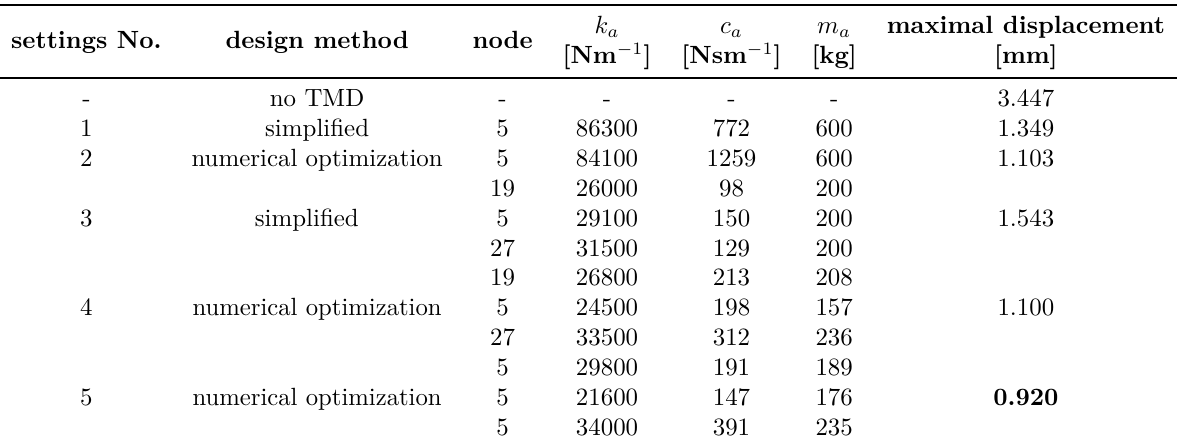
Table 3. Comparison of design methods and peak response between 1.7-2.2 Hz.